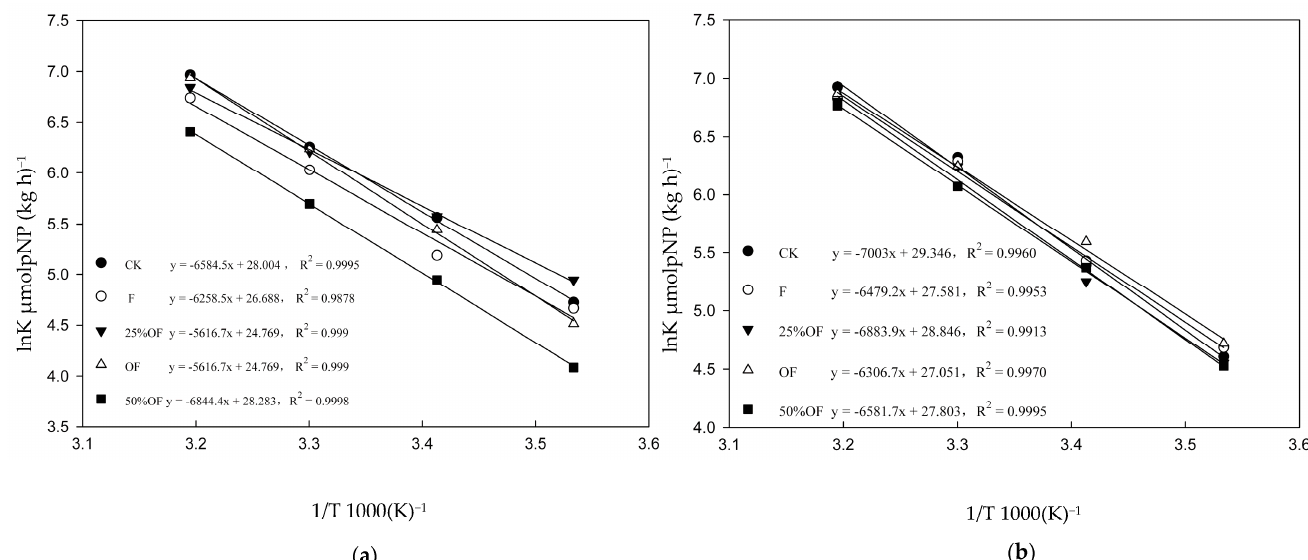
Figure 2. Linear transformation plots of the Arrhenius equation for β − glucosidase activity in soils on jointing stage ( a ) and booting stage ( b ) of spring wheat at temperatures ranging from 10 to 40 °C. CK indicates no fertilizer treatment. F indicates single fertilizer treatment. 25% OF indicates 25% organic fertilizer plus 75% chemical fertilizer treatment. OF indicates organic fertilizer treatment. 50% OF indicates 50% organic fertilizer plus 50% chemical fertilizer treatment.